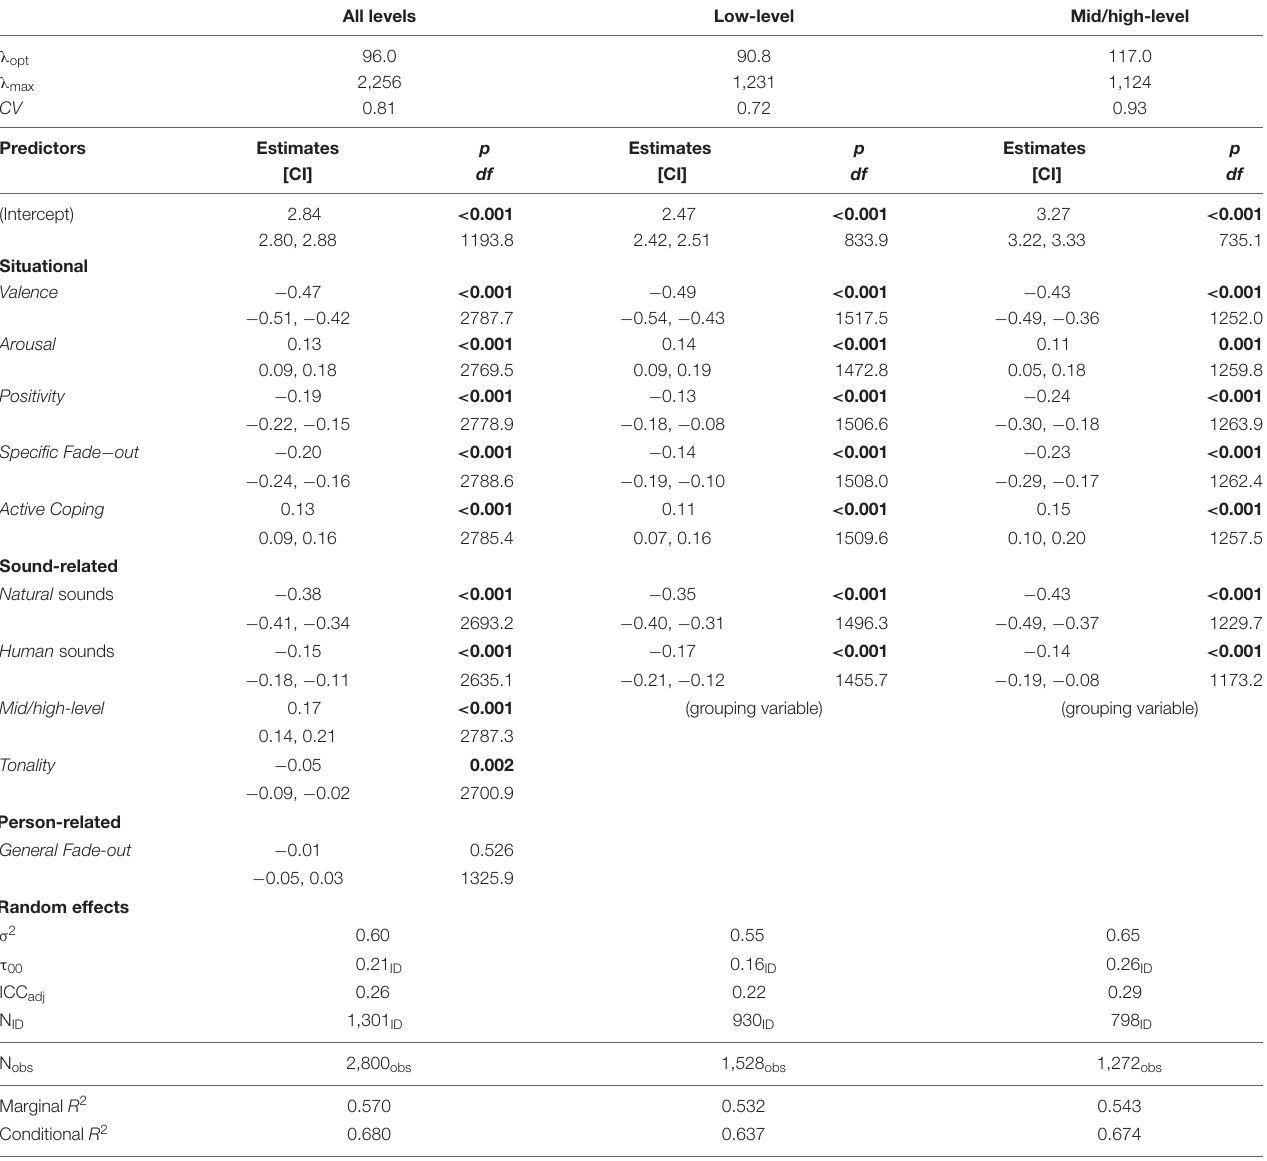
TABLE 6 | Estimations of Lasso-selected parameters for the full dataset and two Loudness subsets. All